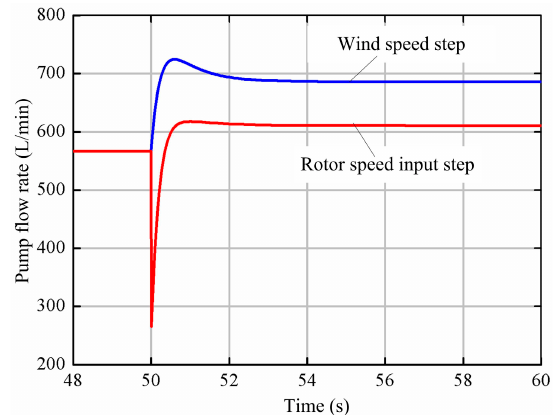
Figure 11. Pump flow rate.